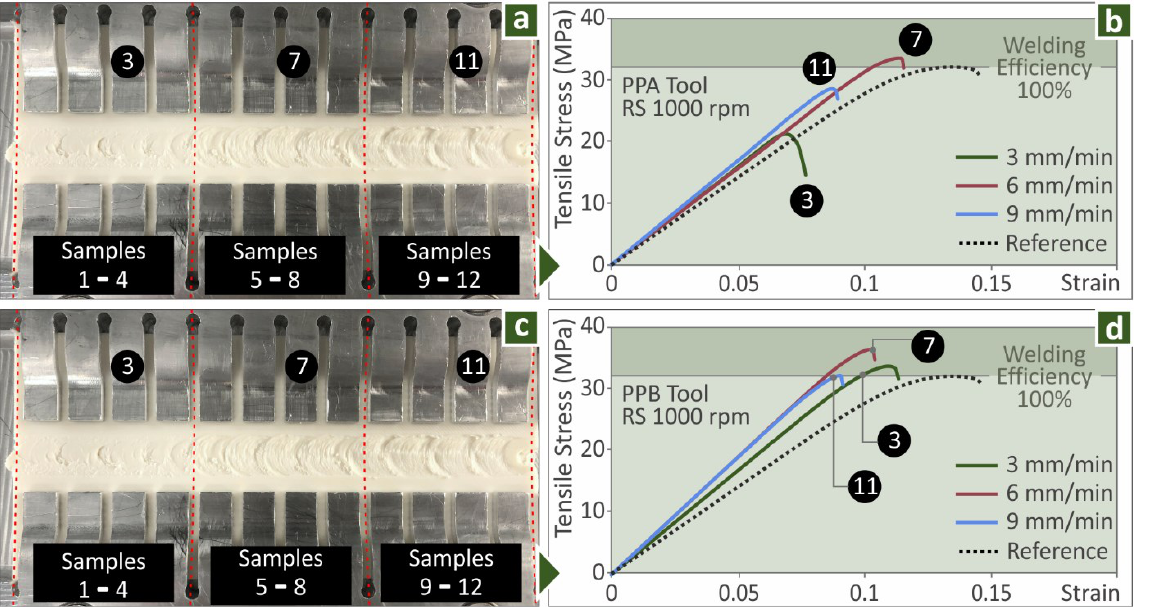
Figure 6. ( a ) FSW with the PPA, ( b ) stress – strain graphs of specimens with the PPA tool, ( c ) FSW with the PPB, ( d ) stress – strain graphs of specimens with the PPB tool.